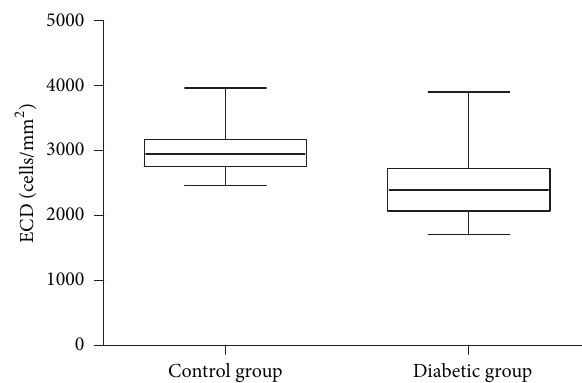
Figure 1: ECD values in patients with diabetes and in the control group.